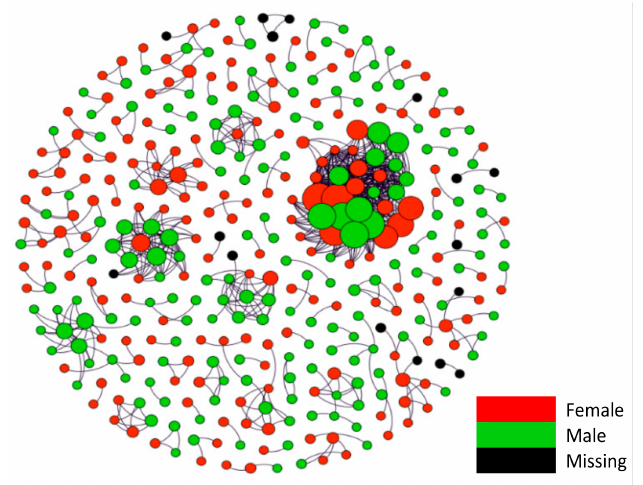
Figure 4. Viral transmission networks by sex.